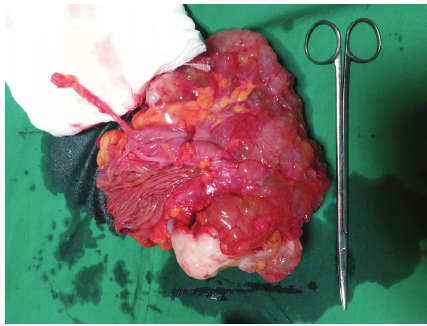
Figure 2: Resected mass with ileocaecum and part of ascending colon. Appendix is also seen. Histopathology on gross examination revealed a cystic mass 21 × 13 × 8cm attached to the serosa of the caecum without any infiltration into the bowel wall.